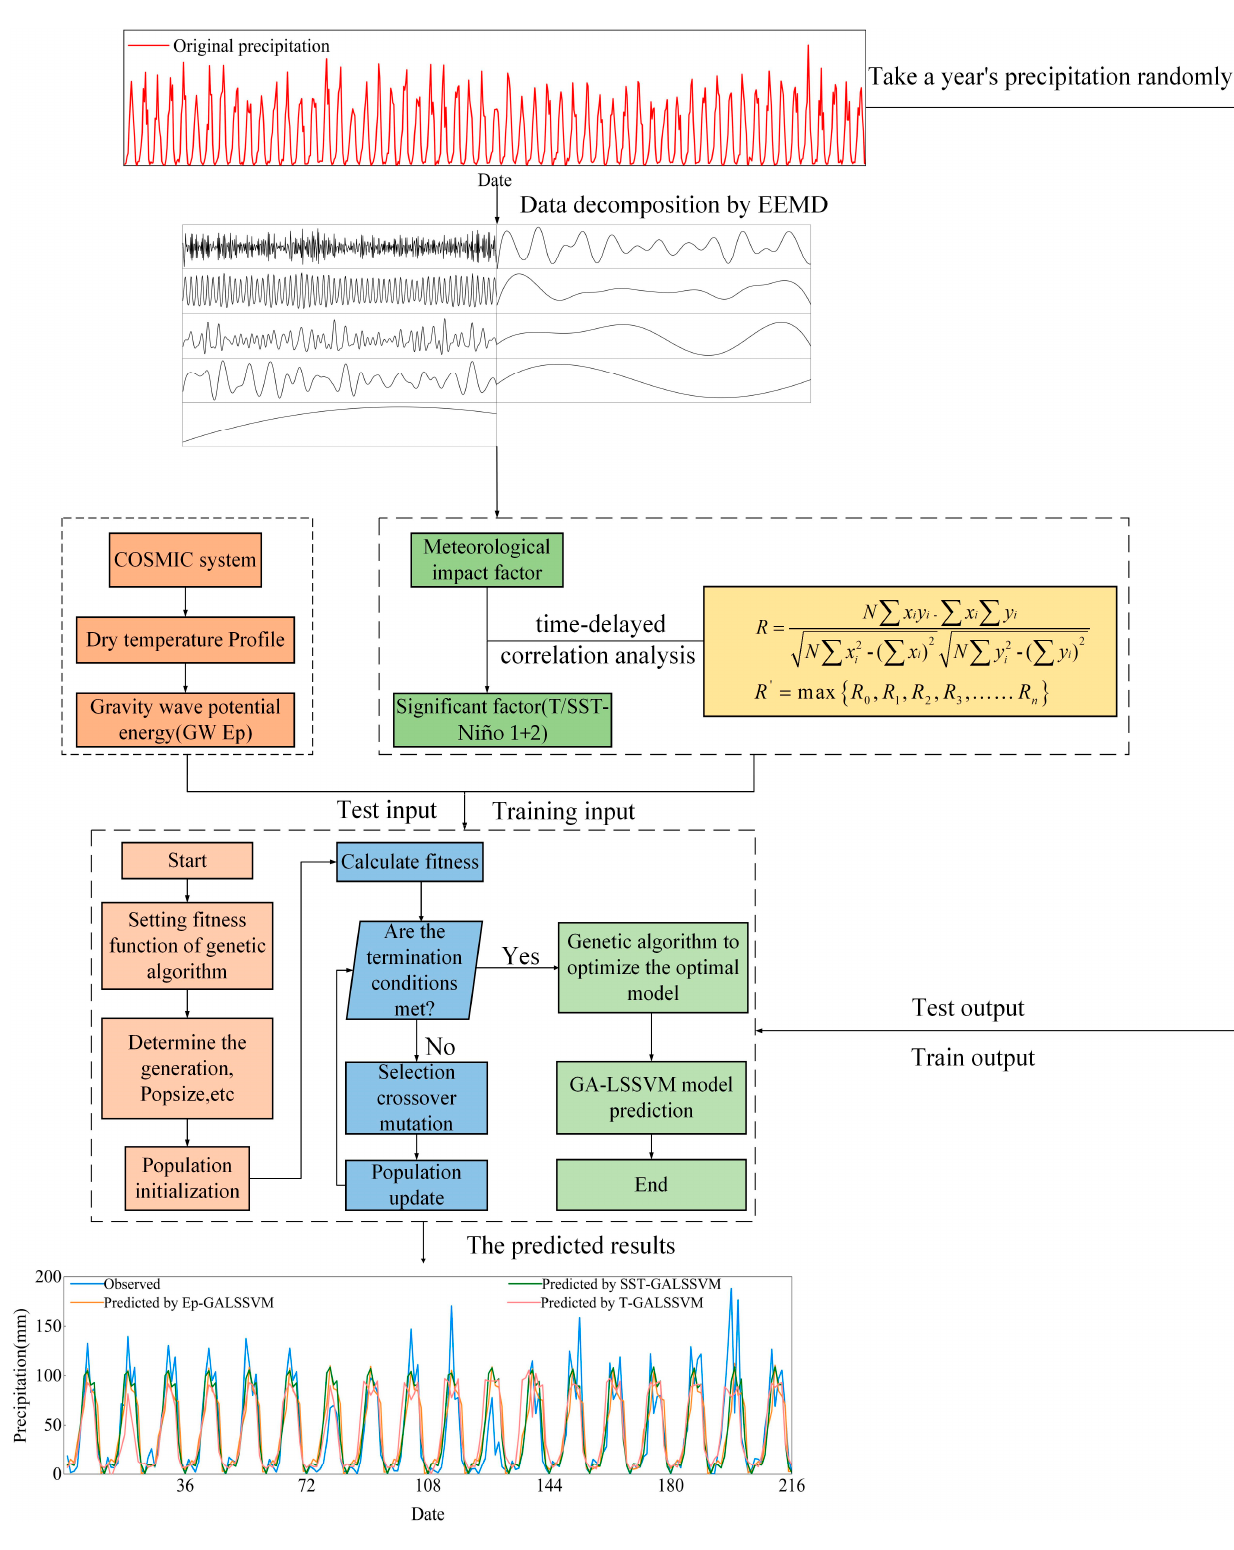
Figure 2. Prediction scheme for precipitation combining with meteorological factors.